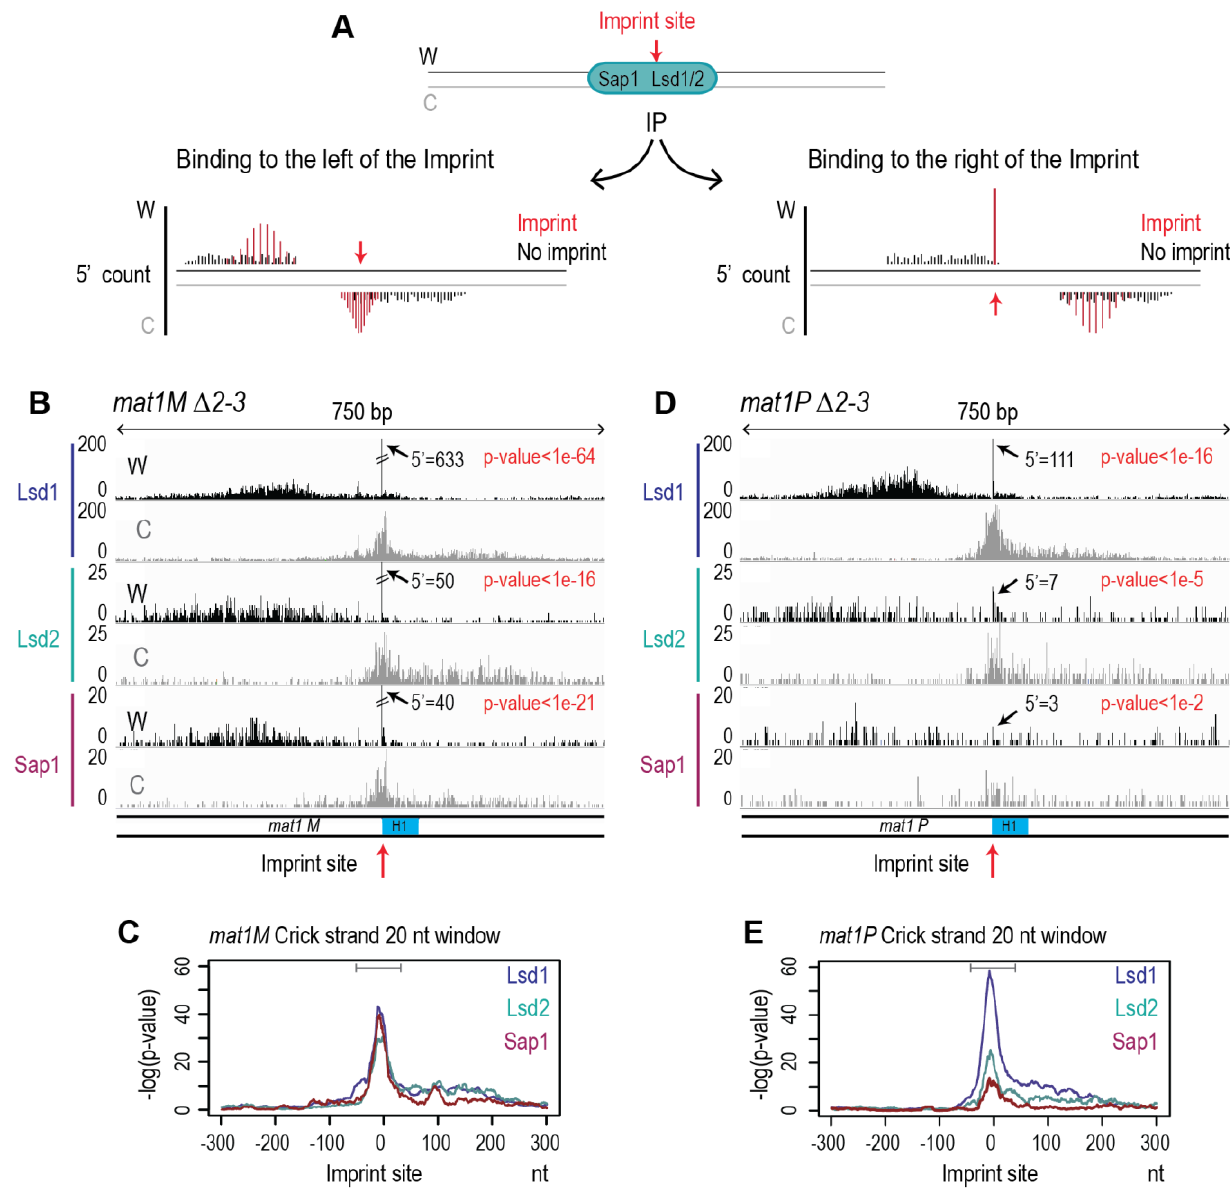
FIGURE 9: Lsd1/2 and Sap1 immunoprecipitate chromatids on both sides of the imprint. Result of the 5' count analysis of the ChIP data presented in Figure 3C. (A) Schematic representation of the theoretical 5' count distribution of Lsd1/2 and Sap1. In black, the 5' count of a non-imprinted chromatid and in red that of an imprinted chromatid. (B) Distribution of the 5' count of the Lsd1/2 and Sap1 ChIPs for the Watson strand (black) and Crick strand (gray) in the mat1M ∆ 2-3 background. The 5' count at the imprint site is indicated. The p-value is calculated using theoretical t-student distributions that fit with the distribution of 5' count observed in the 10-kb region that contains mat1 . (C) Analysis of the 5' count bias on the crick strand using a 20 nt window in a mat1M ∆ 2-3 strains for the IPs of Lsd1-2 and Sap1. A sliding window of 20 nt with set size one is used in a 10 kb region around mat1 is applied. Gray line indicates the bias of the crick across the imprint. (D) Same as in (B) in a mat1P ∆ 2-3 strain. (E) Same as in (C) in a mat1P ∆ 2-3